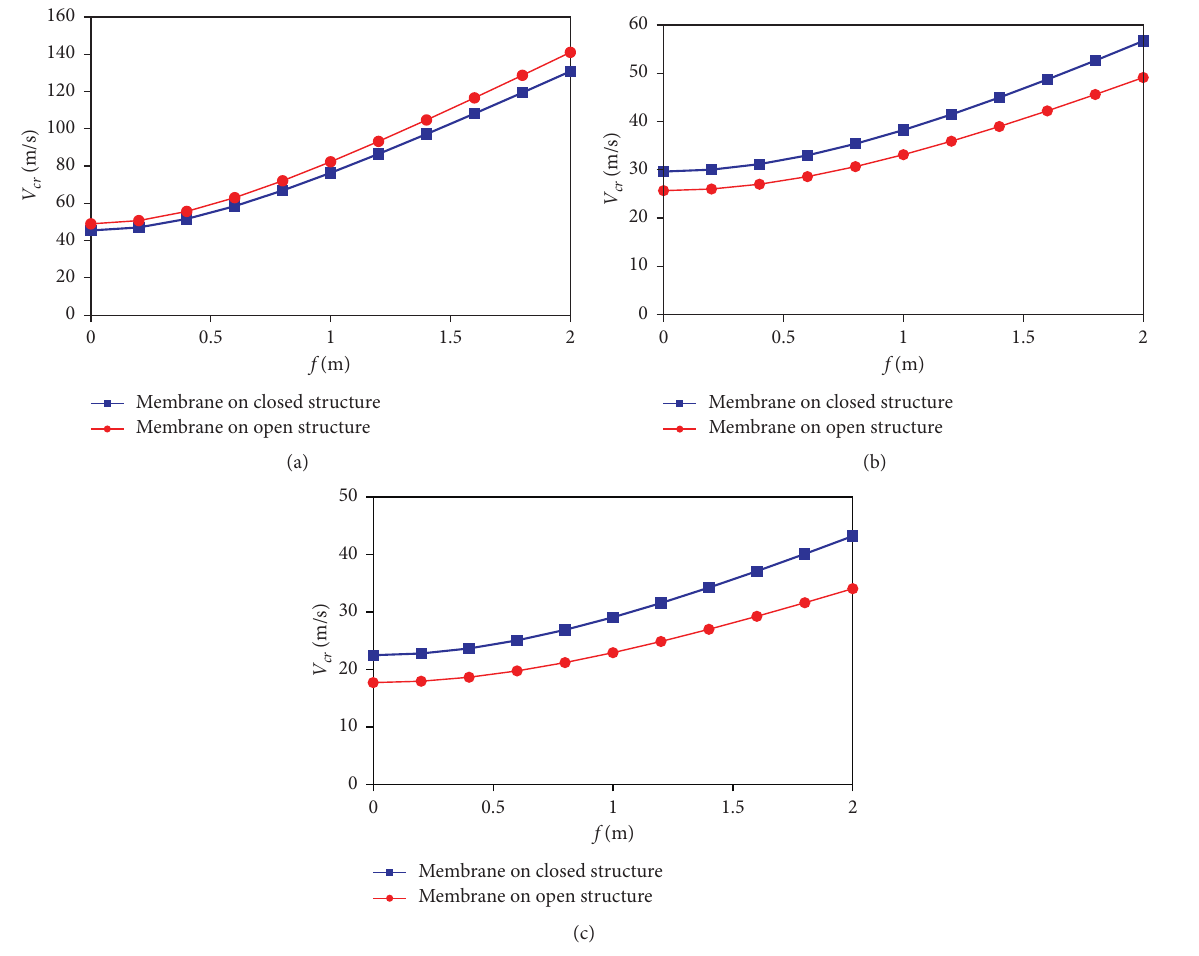
Figure 5: Curves of critical wind velocity with amplitude for two types roof models. (a) λ � 0.5. (b) λ � 1. (c) λ � 2. Table 3: Ratio of critical wind velocity of the membrane roof on the closed structure with and without considering geometric nonlinearity. f � 0.1 m f �